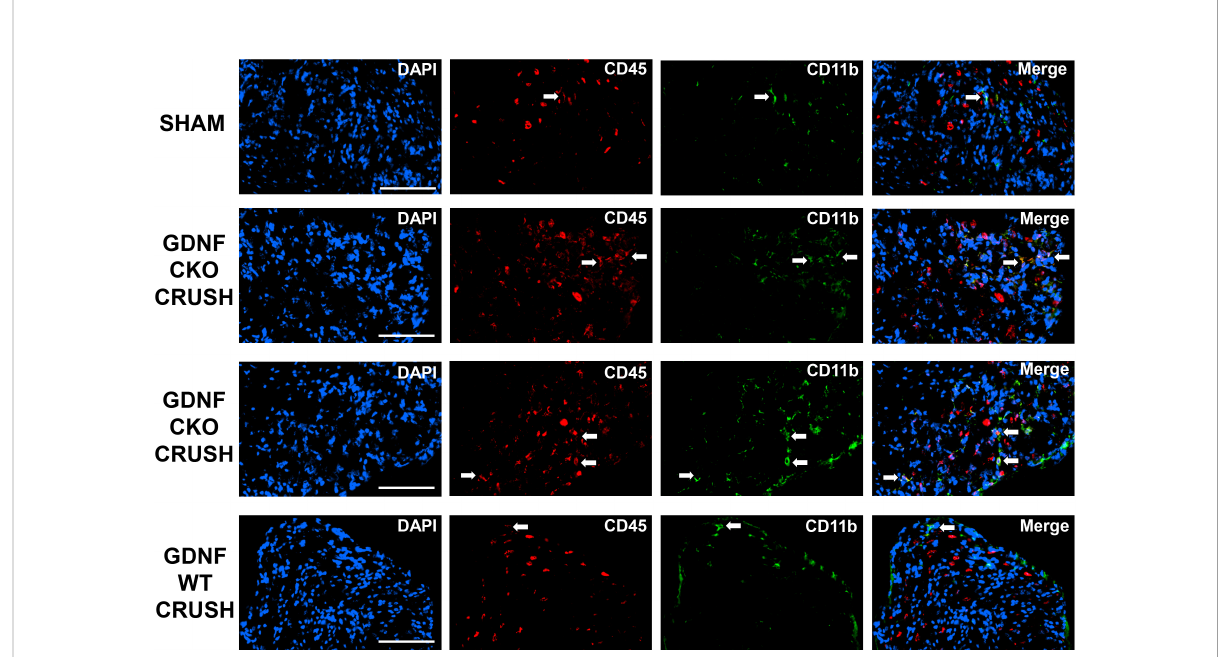
FIGURE 5 L5 lumbar DRG CD11b+ CD45+ leukocyte in fi ltration in Tamoxifen-induced Gdnf CKO and Gdnf WT on day 14 following unilateral sciatic nerve crush injury. Representative digital axial photomicrographs of mouse L5 DRGs show rare positive-staining leukocytes (white arrows) in Sham surgery control L5 DRGs. Sciatic nerve crush injury is associated with increased L5 DRG leukocyte in fi ltration. More CD45+ leukocytes are seen in Gdnf CKO mice compared to Gdnf WT mice at a time point associated with expected early axonal regeneration, with higher numbers of